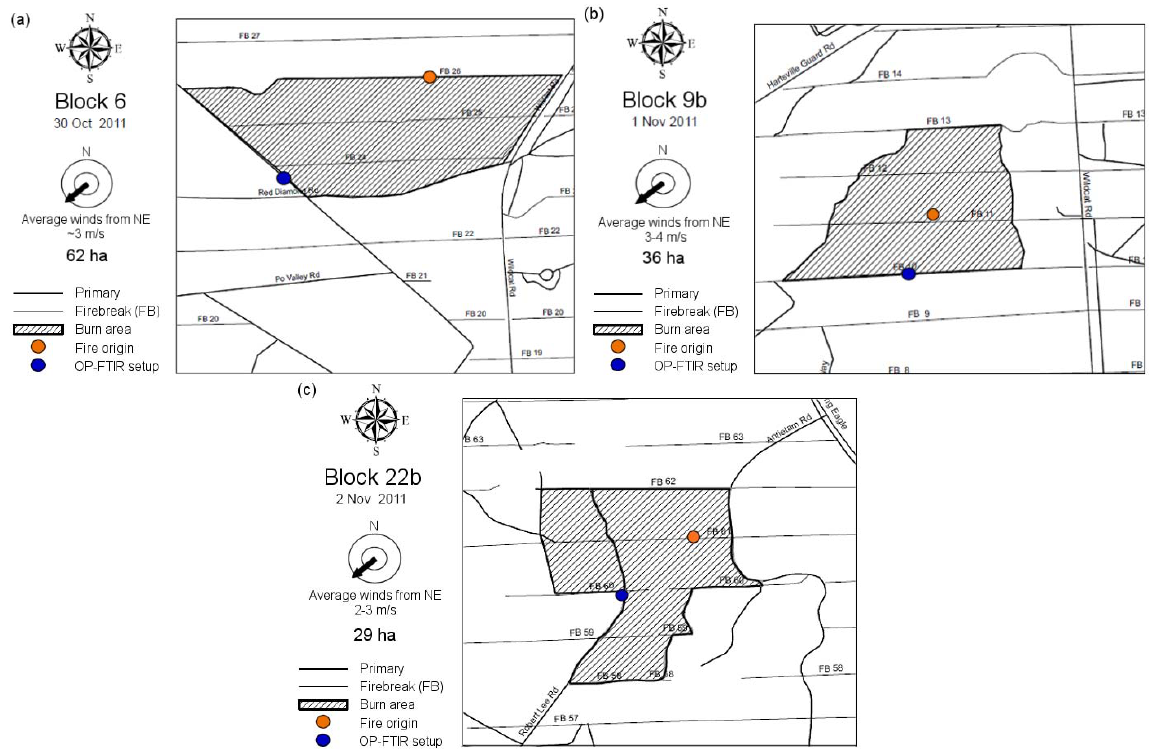
Fig. 2. Detailed burn maps of (a) Block 6, (b) Block 9b, and (c) Block 22b prescribed fires at Fort Jackson, SC. The location of the OP-FTIR is shown as a blue circle. The location where the fire was first lit is shown by the orange circle. Fires were typically lit along firebreaks in a continuous line with the “fire origin” representing where the fire-line was